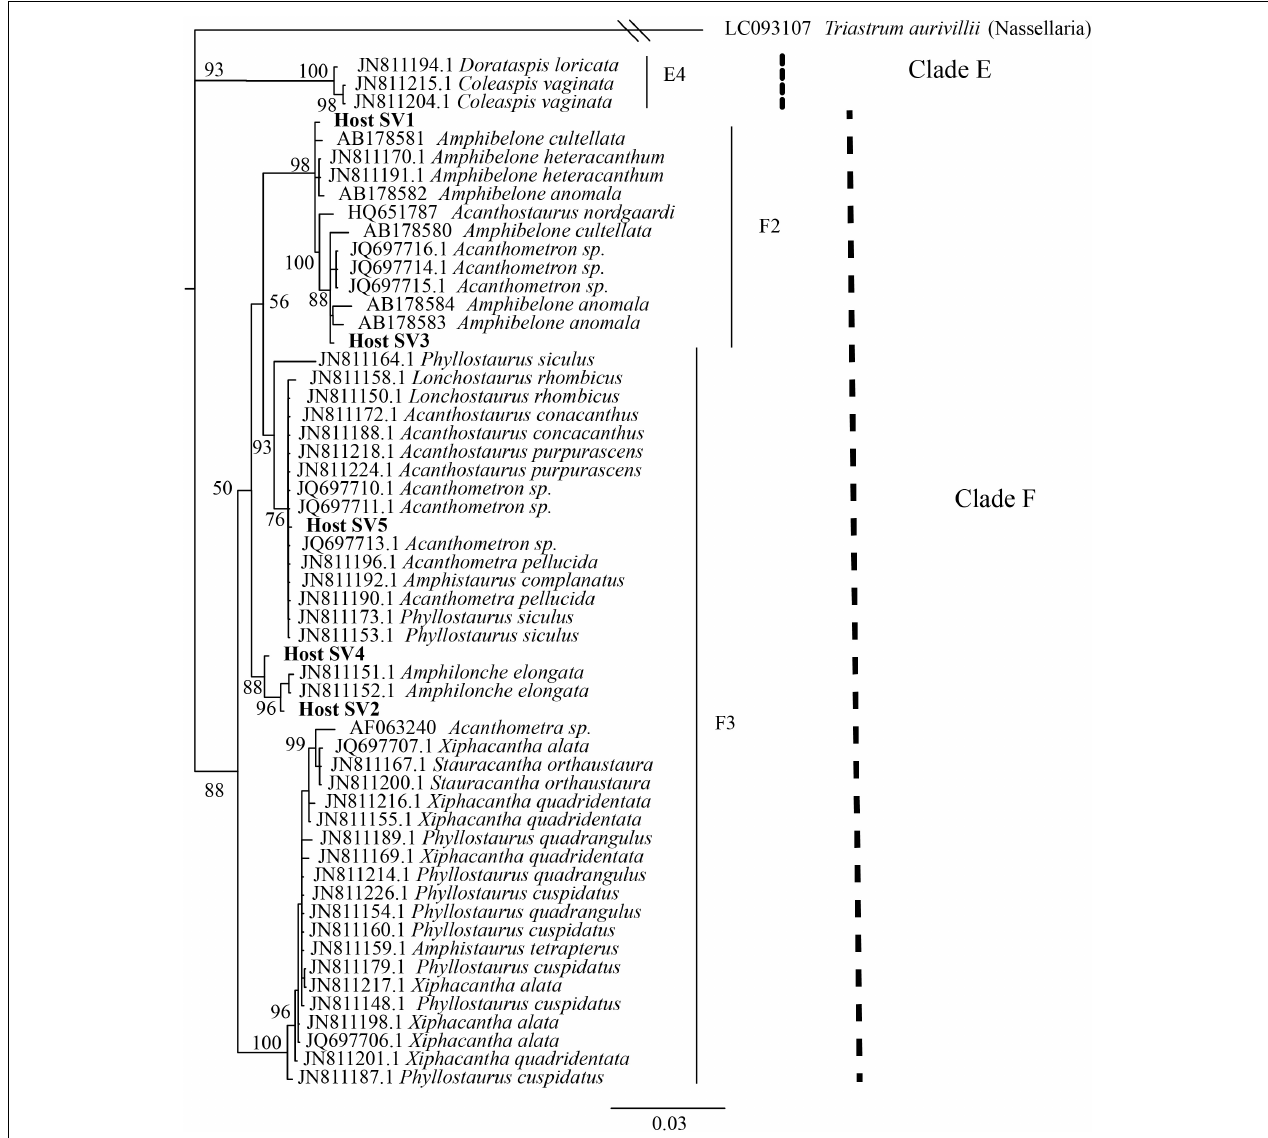
FIGURE 3 | Phylogenetic placement of acantharian host SVs. The phylogenetic tree was built from a MUSCLE v3.8.31 alignment of the 5 dominant host SVs and GenBank reference sequences representing clades E and F Acantharea and the nasellarian radiolarian Triastrum aurivillii (outgroup). The tree was built with MrBayes v3.2.7. Values associated with nodes are posterior probabilities as a percent after 40,000 generations (average SD of split frequencies = 0.01). The scale bar indicates 0.03 changes expected per